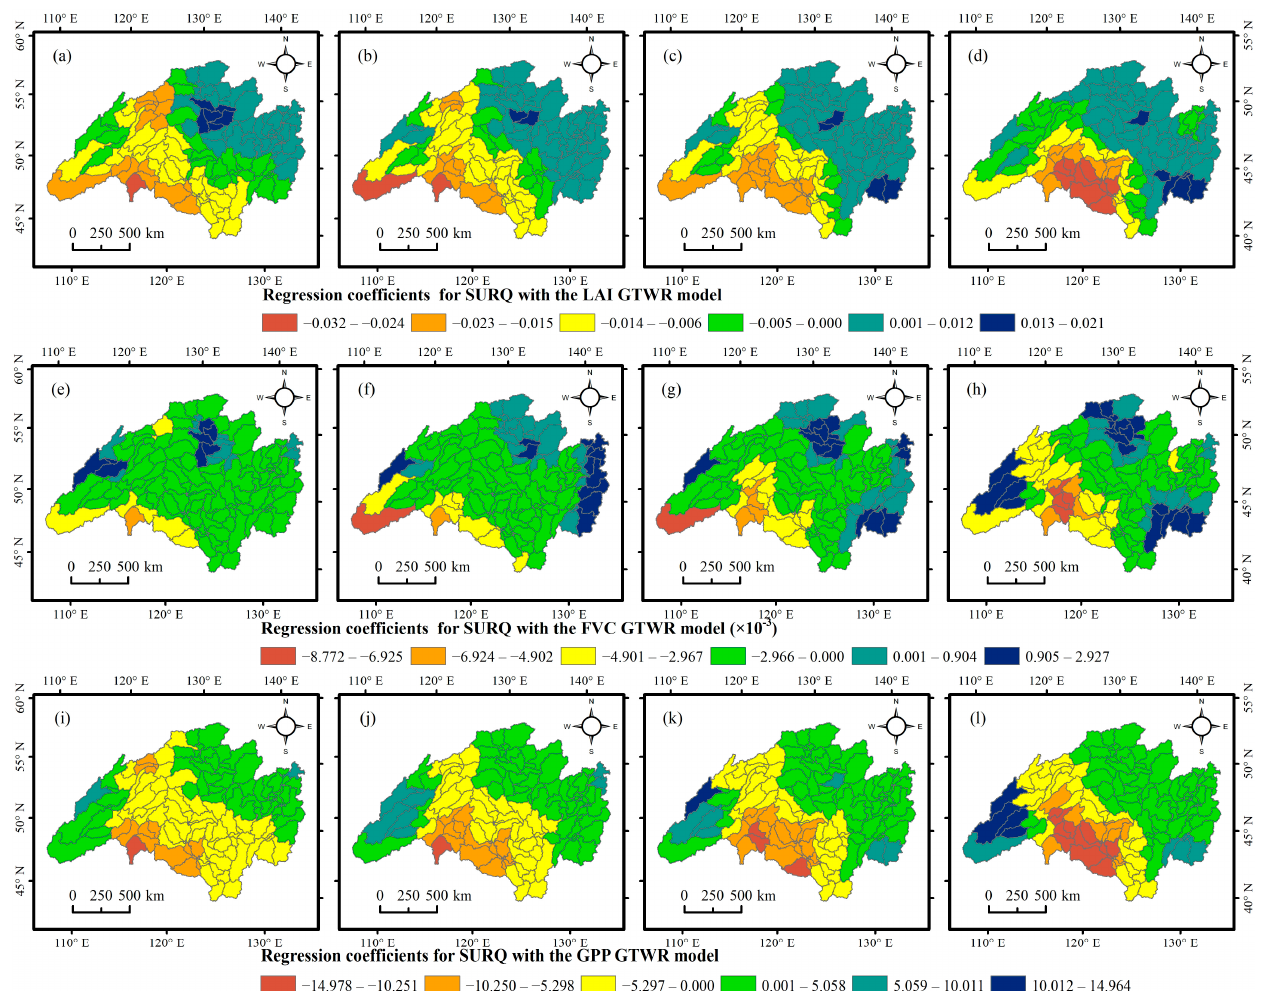
Figure 8. The spatial distribution of the regression coefficients for SURQ with the LAI (( a – d ) shows the coefficients for Periods 1–4, respectively), FVC (( e – h ) presents the coefficients for Periods 1–4, respectively), and GPP (( i – l ) exhibits the coefficients for Periods 1–4, respectively) GTWR models for the four studied periods.